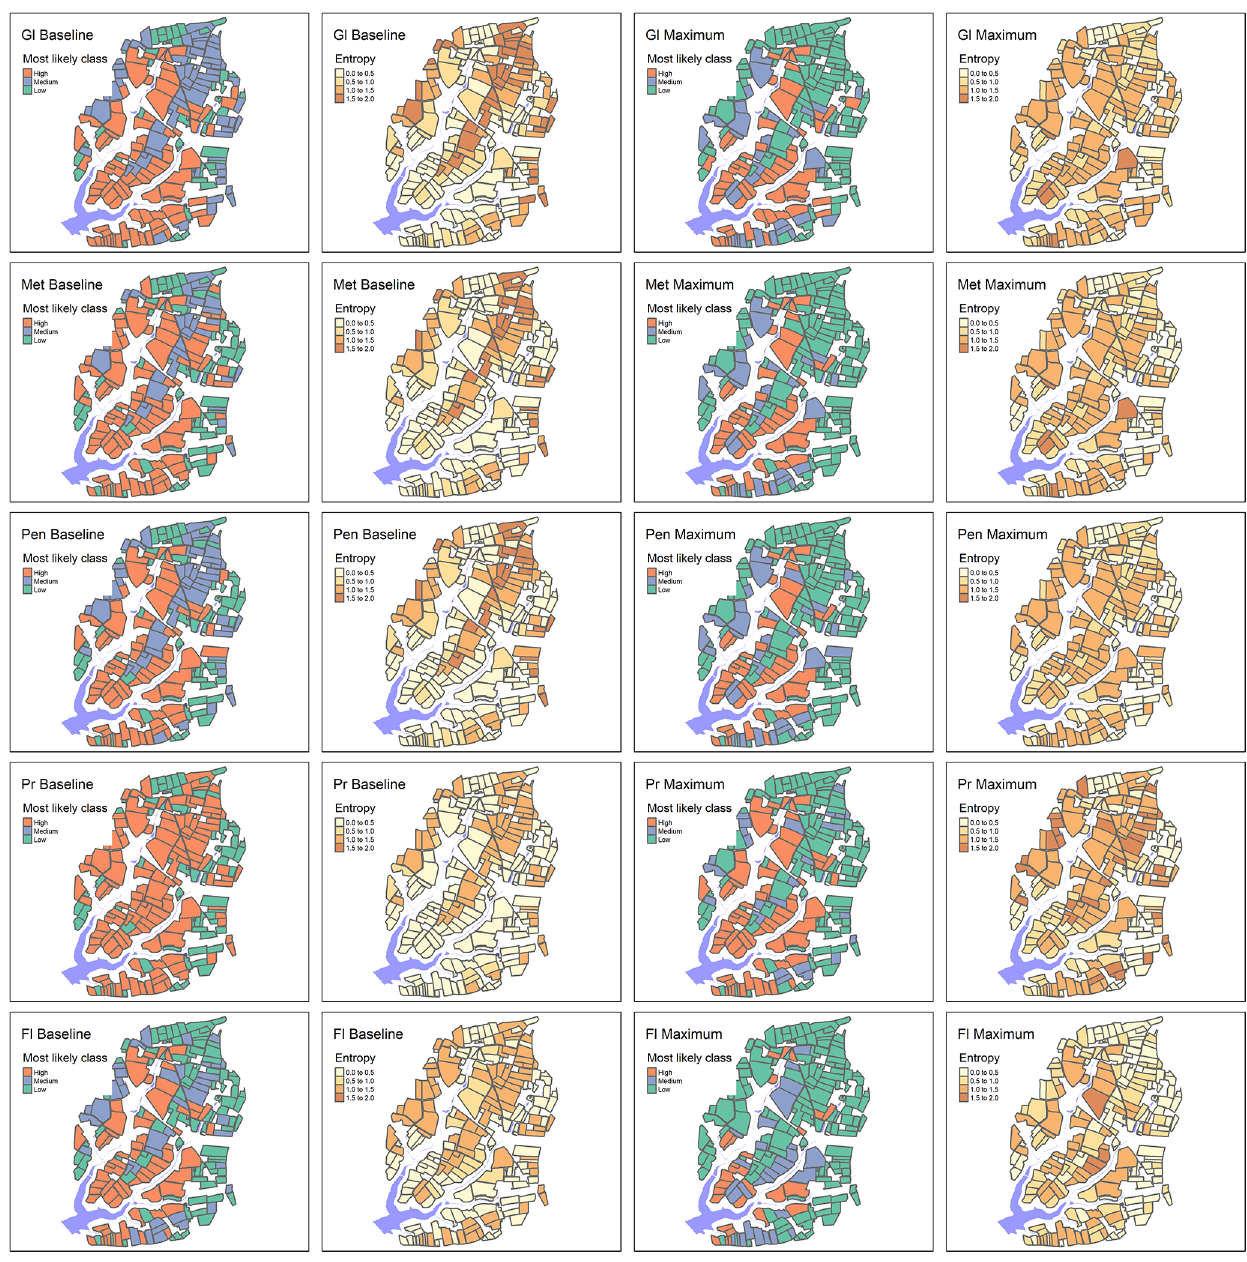
Figure 5. Spatial variability and associated uncertainty (entropy) in the overland runoff pesticide loads under current practices for the five active ingredients under baseline and maximum mitigation scenarios: Gl – glyphosate, Met – metobromuron, Pen – pendimethalin, Pr – prosulfocarb, and Fl –